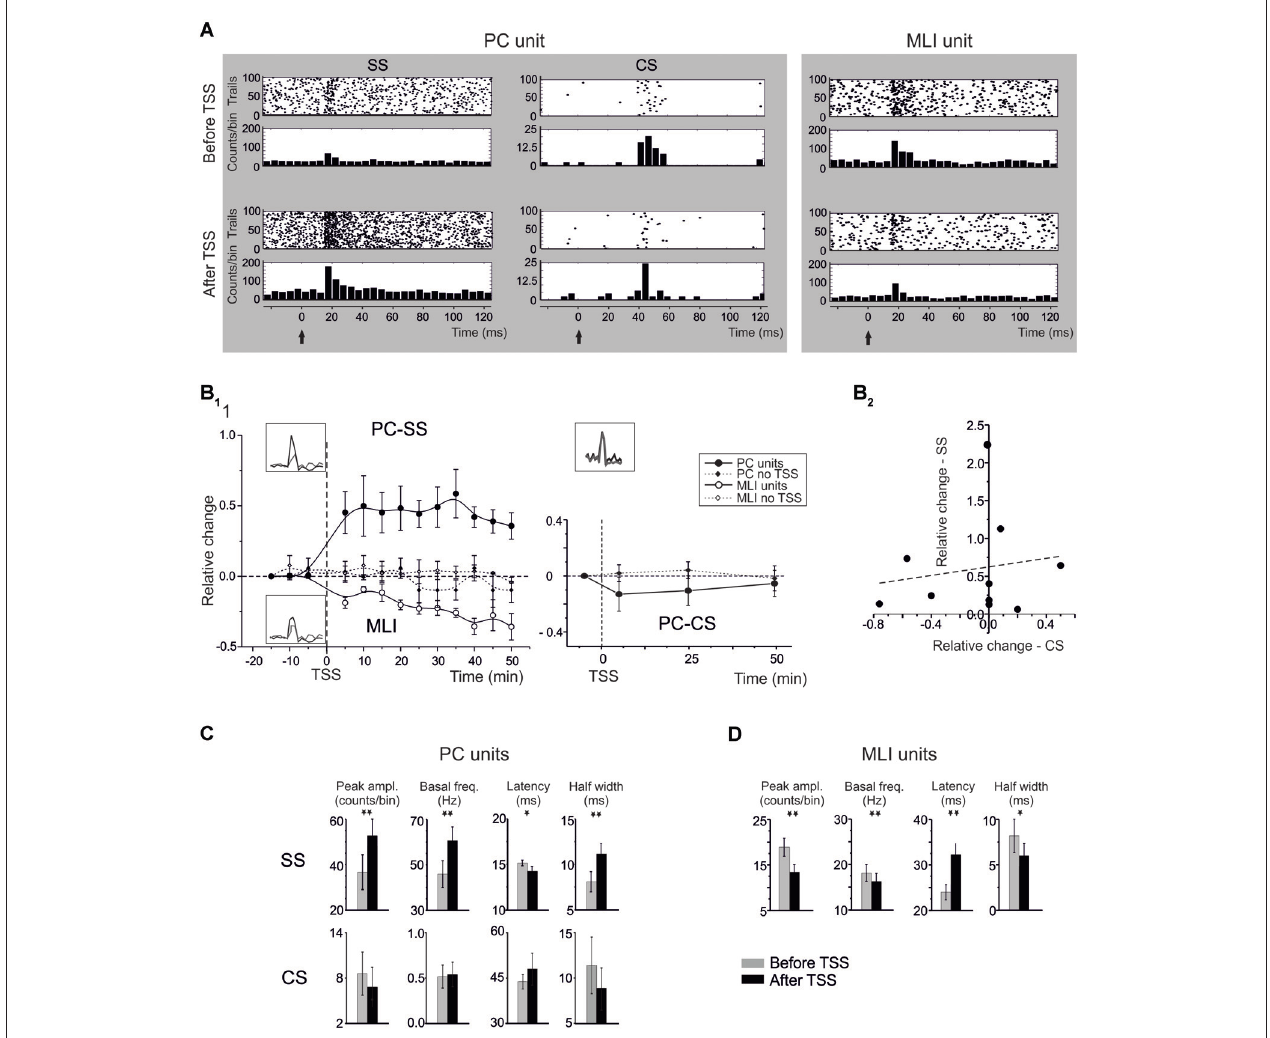
FIGURE 2 | Spike-related plasticity in PCs and MLIs following sensory stimulation. (A) Raster plot and PSTH of a representative PC (left panel) and MLI (right panel) responding to air-puff stimulation. The raster plot and PSTH is made from 100 consecutive sweeps recorded before (upper panels) and after (bottom panels) TSS application. The PCs response is reported for SS and CS separately. TSS increases the number of SS generating a dense cloud immediately after the stimulus onset (black arrow) in the raster plot and increasing the PSTH peak (5 ms time bin). Conversely, TSS does not significantly influence the CS response. The MLI response shows a significant decrease in the number of spikes generating a sparse cloud immediately after the stimulus onset (black arrow) in the raster plot and decreasing the PSTH peak. (B) Time course of the normalized changes of PSTH peak amplitude (mean ± MSE). In the left plot, SS spike firing in PCs ( n = 13) and MLI ( n = 11) firing are compared to control recordings in which TSS was not applied (PC: n = 6; MLI: n = 4). After TSS, PCs units show SR-P, while MLI units show SR-S . In the right plot, CS firing changes after TSS ( n = 9) are compared to control experiments in which TSS was not applied ( n = 6). No significant changes occurred in the CS response. (C) Relative change of SSs firing frequency after TSS plotted against the relative changes of CSs firing frequency after TSS. The plot demonstrates absence of correlation between SS and CS changes after TSS. The dotted line is a linear regression on the data-set (adj. R 2 = − 0.096, prob ( > F) = 0.66). (D) The histograms show variations (mean ± MSE) of peak amplitude, latency and duration of the PSTH peak as well as of basal frequency for both PC SS and CS and for MLI. ∗ p < 0.05, ∗∗ p < 0.01, otherwise